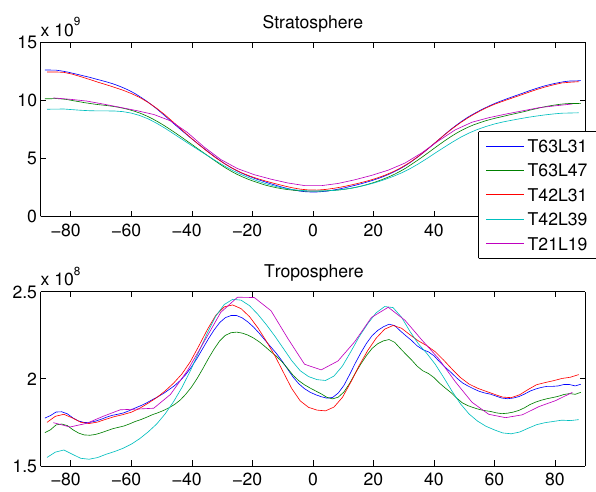
Fig. 9. Zonal mean stratospheric and tropospheric column density of 10 Be atoms (concentration integrated over the atmospheric column m − 2 ) with different model resolutions.